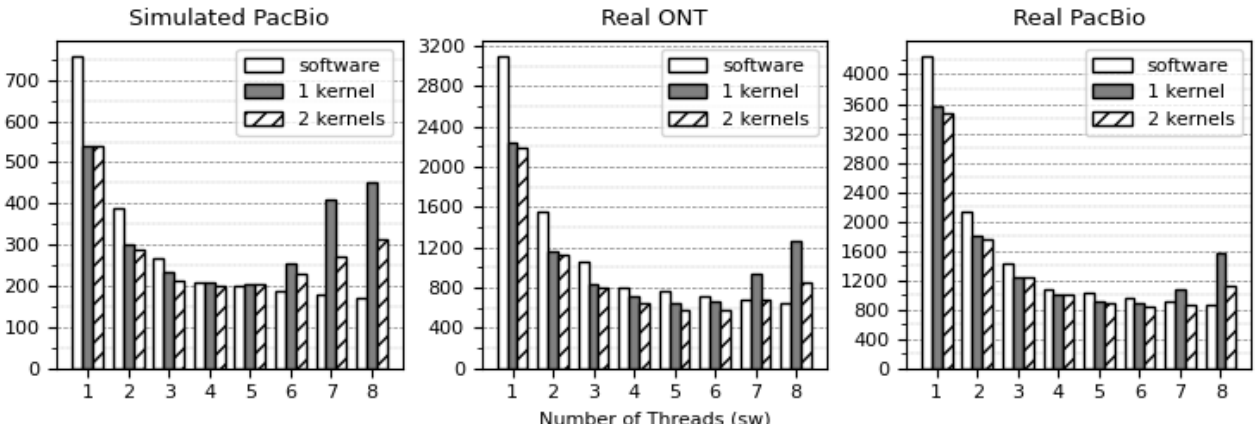
Figure 9. Processing times for Minimap2 in software with the ksw function and for the integrated hybrid system Minimap2-GACT-X. Each chart corresponds to one of the three datasets used as inputs. The hybrid system may run with 1 or 2 kernels (gray and hatched bars, respectively). Minimap2 can be set to run in multi-thread mode (with 1 to 8